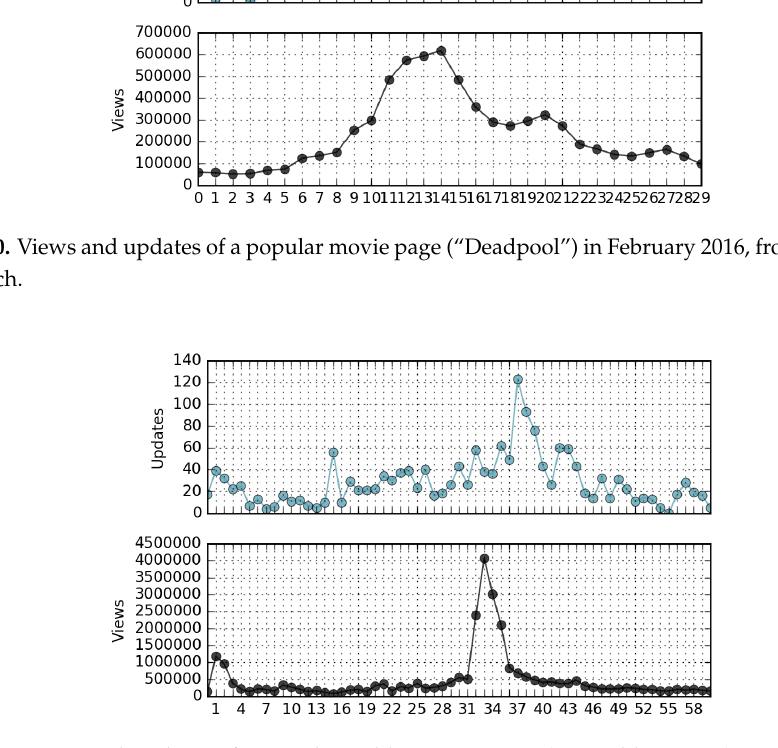
Figure 11. Views and updates of a popular public person page (“Donald Trump”) in February 2016, from 1 February to 1